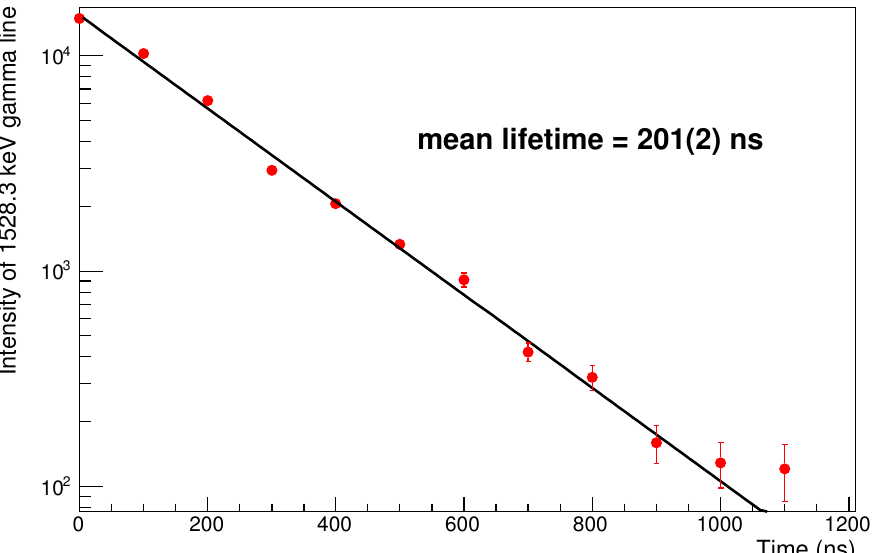
Figure 5. Time evolution (in 100 ns wide windows) of the intensity of 1528.3 keV gamma-ray originating from the de-excitation after muon capture in the Fe nucleus, shown by red filled circles. The formula I ( t ) = I [ exp ( − t / τ )] is fit to the data, represented by the black solid line (see also Equation